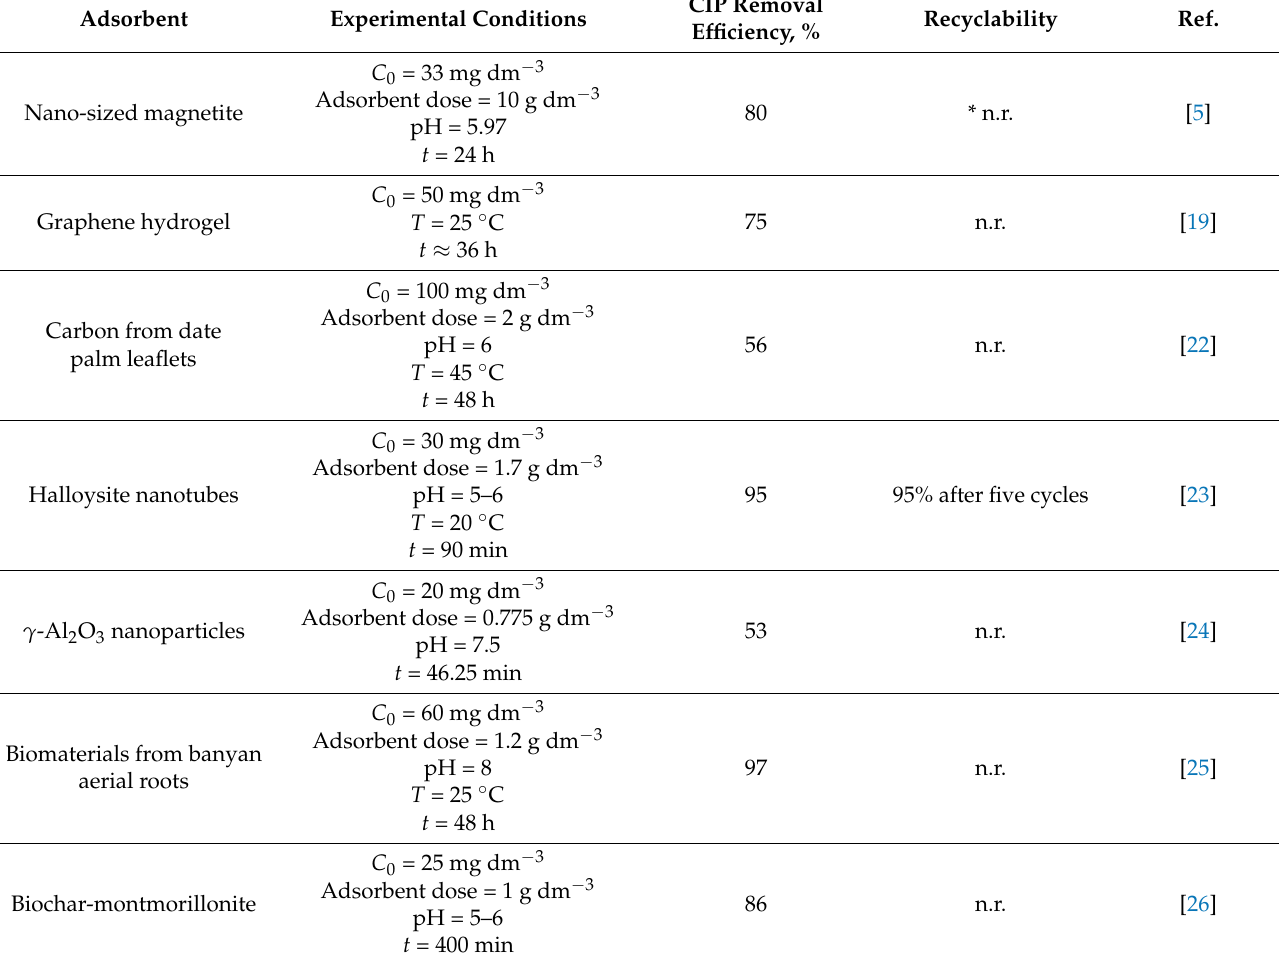
Table 1. Removal efficiency of ciprofloxacin on different types of adsorbent. Adsorbent Experimental